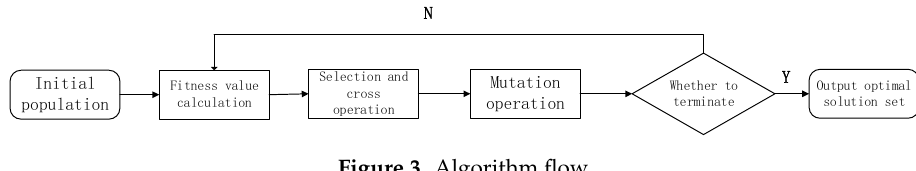
Figure 3. Algorithm flow.